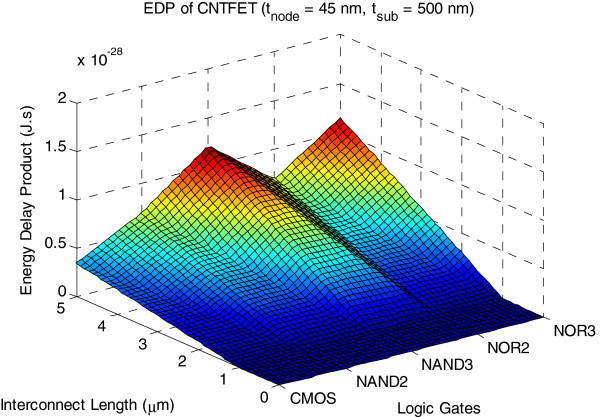
3D plot of EDP of CNTFET logic gates. The copper interconnect length up to 5 μm for tnode = 45 nm and tsub = 500 nm.